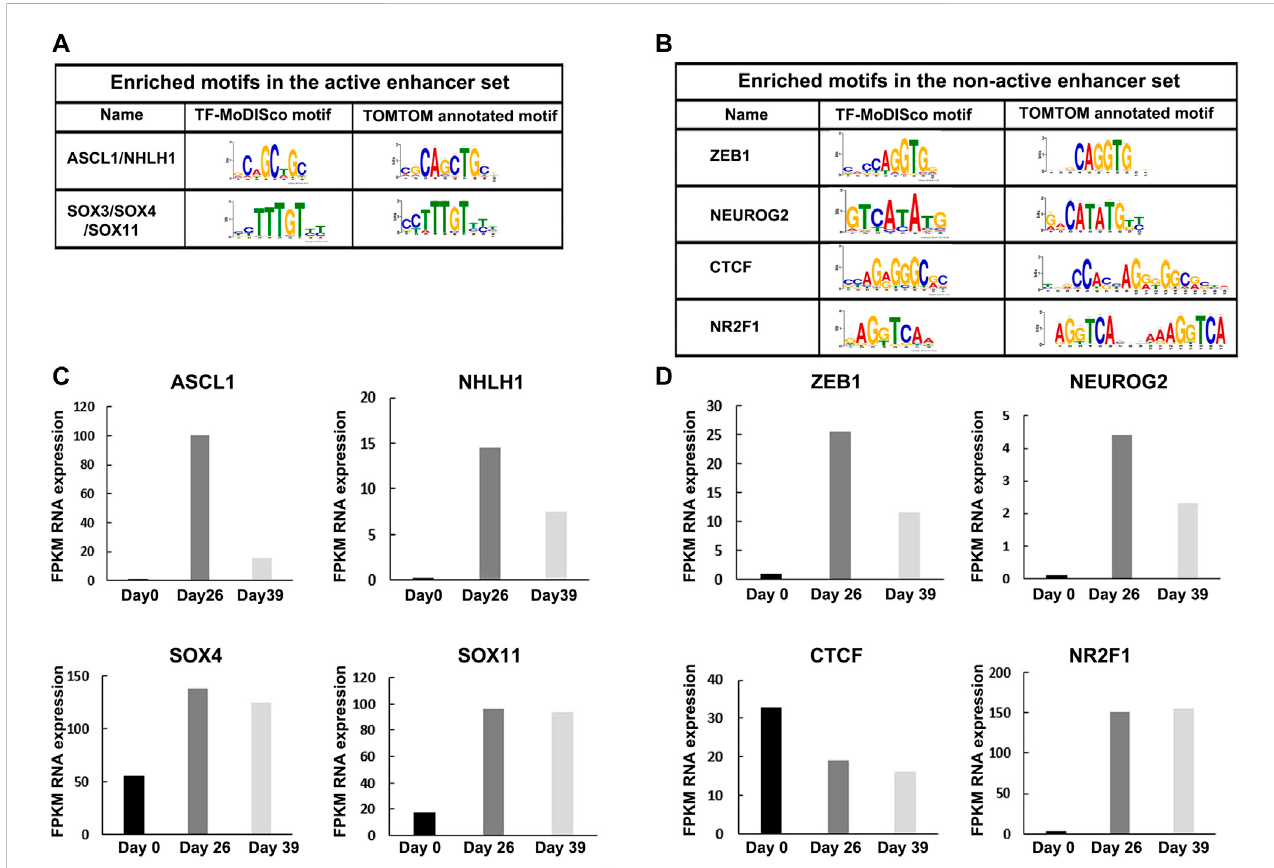
FIGURE 3 Enriched motifs in active and non-active enhancer sets with differential RNA expression levels at Day 26. (A) Enriched motifs in active and (B) non-active enhancer sets following a motif analysis using TF-MoDISco and TOMTOM. (C) RNA expression levels of NHLH1, ASCL1, and SOX4/11 TFs were highly expressed in the active set at Day 26. (D) RNA expression levels of ZEB1, NEUROG2, CTCF, and NR2F1 TFs were highly expressed in the non-active set at Day